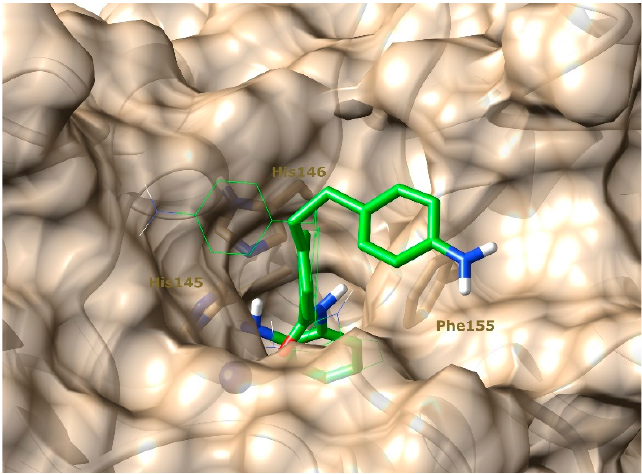
Figure 7. Representation of compound ( 5 ) conformation predicted by molecular docking (green line) and accessed during molecular dynamics simulation (green stick), in complex with HDAC-2 (tan surface and ribbons). Highlighted residues PHE155, HIS145, and HIS146, are important for the interaction with compound ( 5 ).